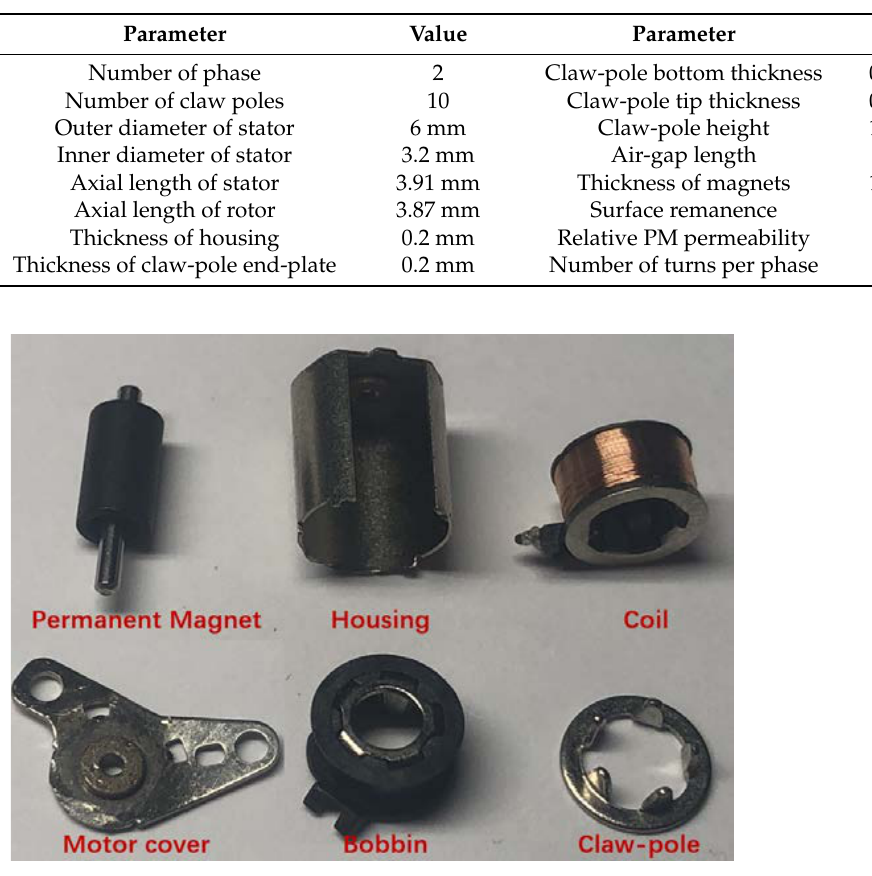
Table 1. Main parameter of prototype motor.